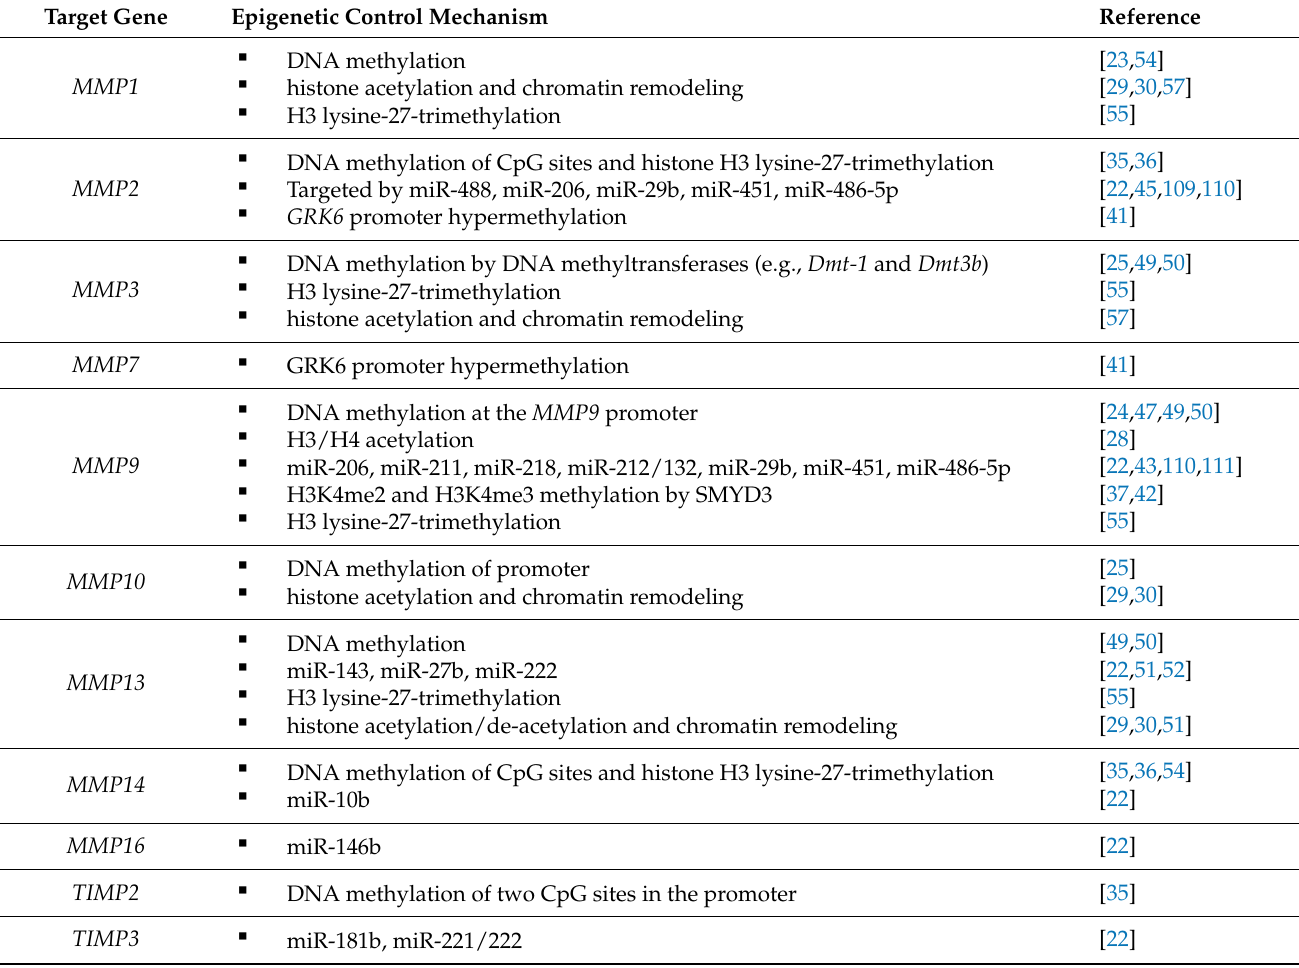
DNA methylation by DNA methyltransferases (e.g., Dmt-1 and Dmt3b )